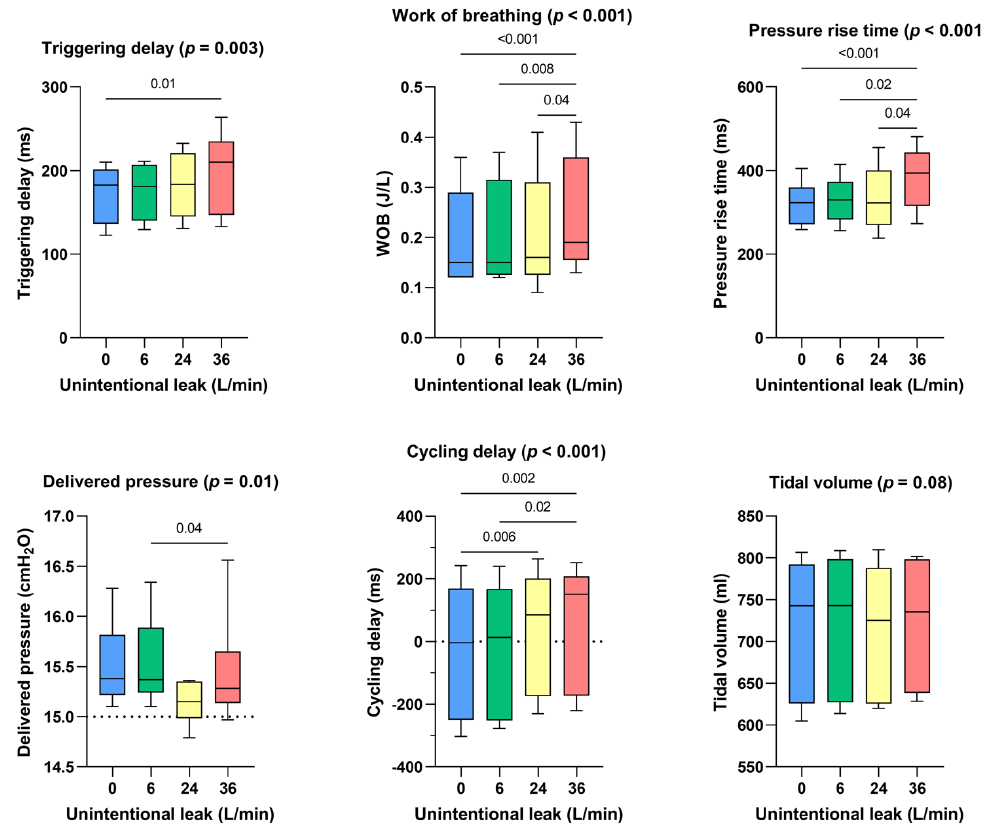
Figure 2. Consolidated data integrating the 3 respiratory models/devices without flow limitation, for the dose response effect between the level of continuous unintentional leakage (0, 6, 24 and 36 L/min) and the following indicators: triggering delays, work of breathing, pressure rise time, delivered pressure, cycling delay and tidal volume.